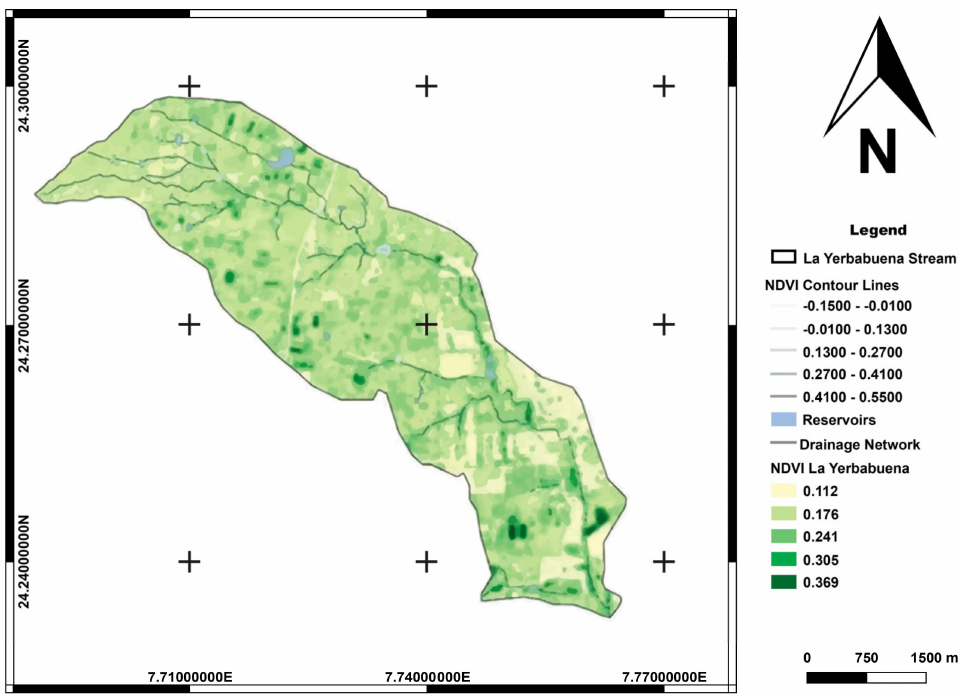
Figure 9. Index of the NDVI vegetation